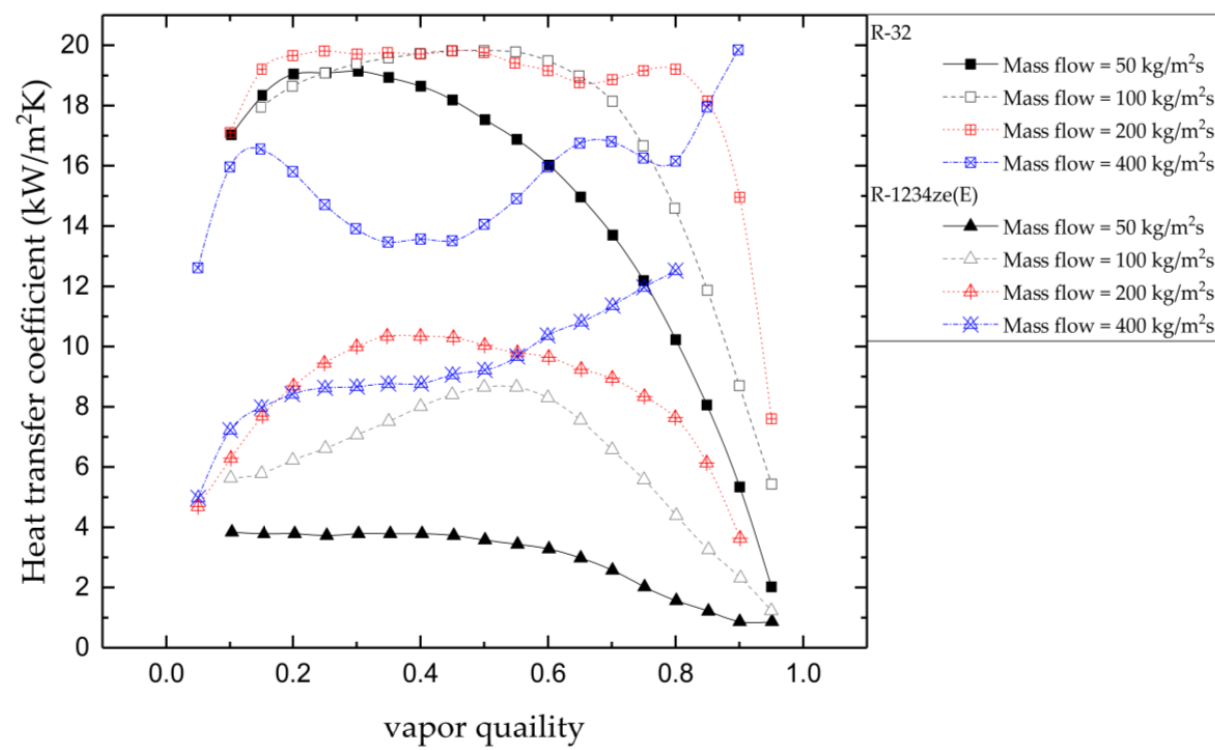
Figure 17. HTCs comparison of R-1234ze(E) and R-32 [77] .